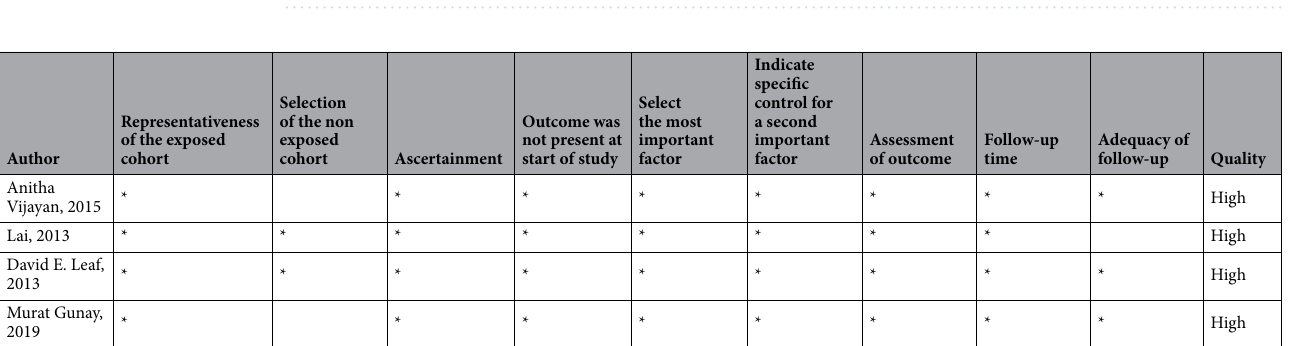
Figure 1. Flow diagram of study selection process.